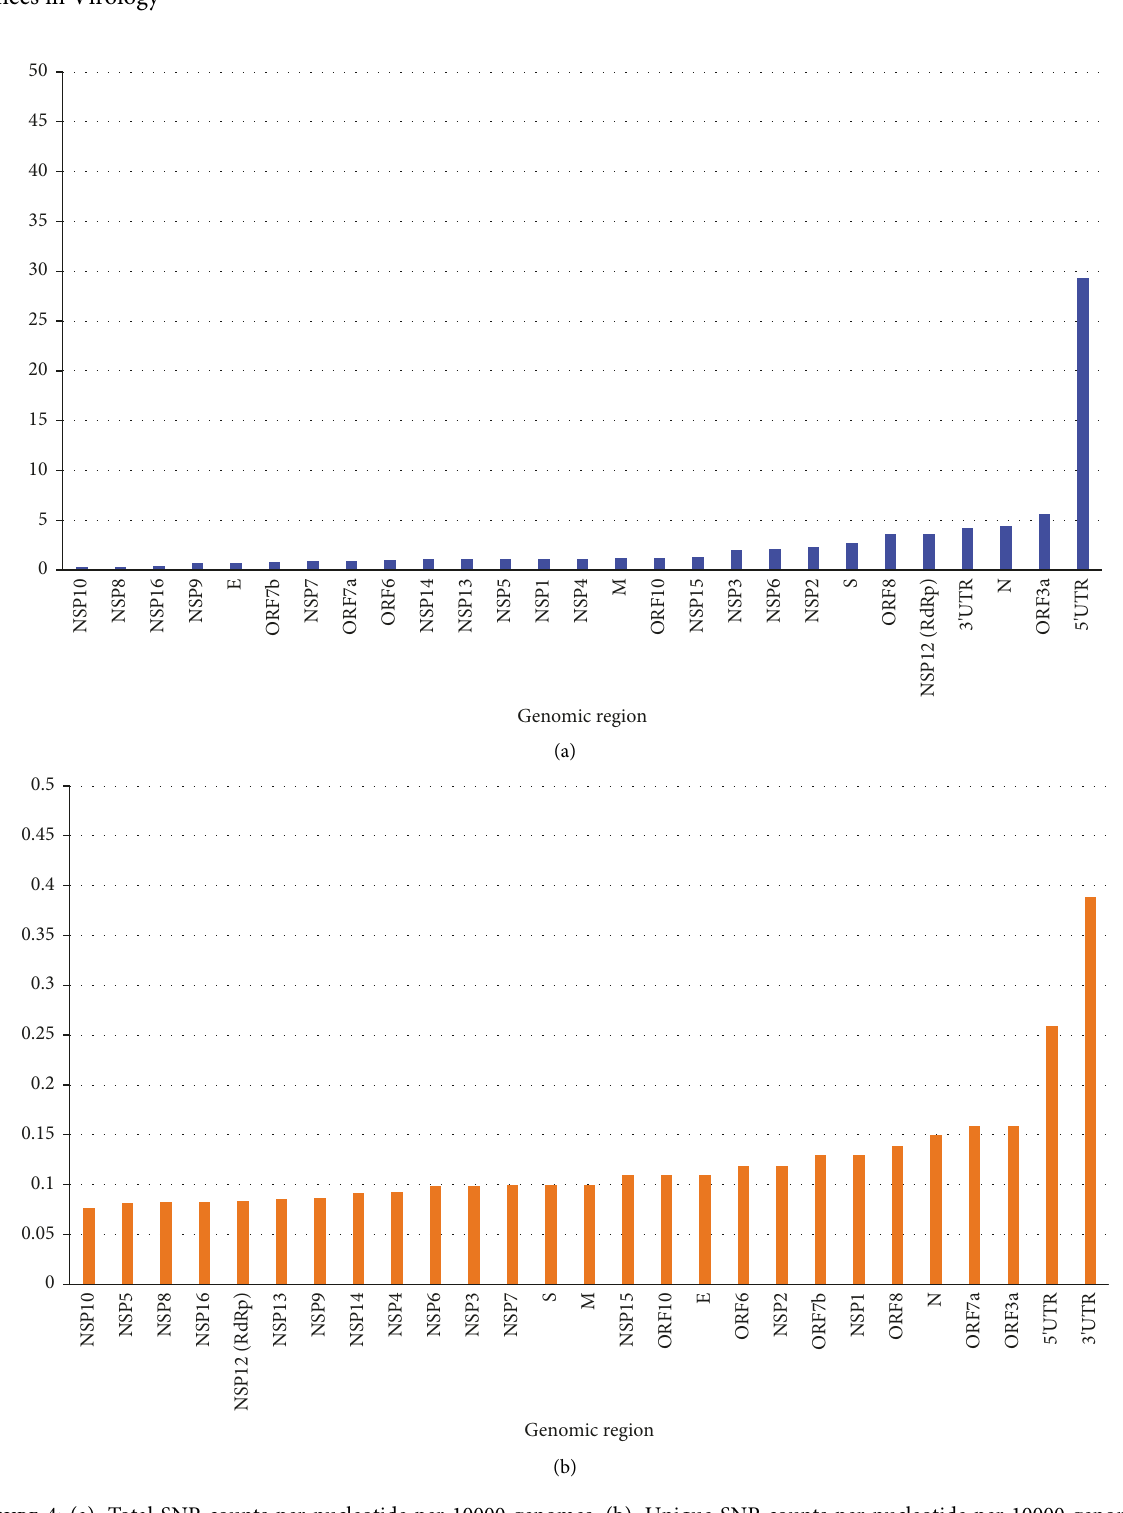
Figure 4: (a). Total SNP counts per nucleotide per 10000 genomes. (b). Unique SNP counts per nucleotide per 10000